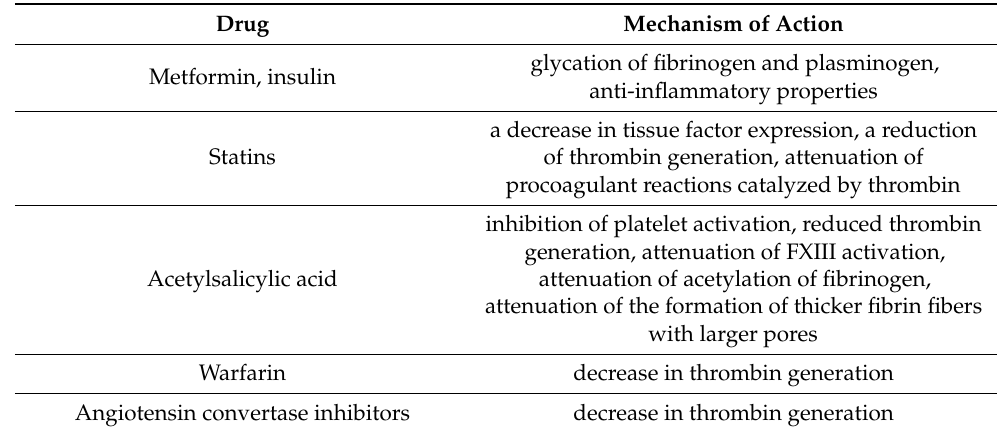
Table 1. Drugs influencing the clot structure